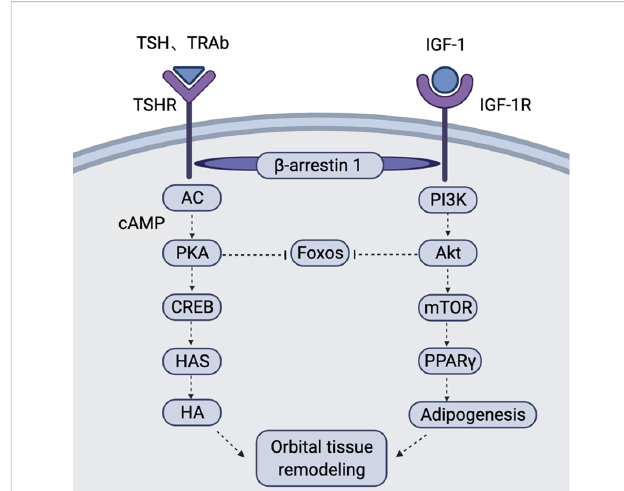
FIGURE 2 Schematic of the TSHR and IGF-1R signalling pathways in the pathogenesis of GO In OFs and OAs of GO patients, TSH and TRAb bind to TSHR to induce activation of AC. This causes an increase in cAMP production and activates PKA. Activated PKA inhibits FOXOs and activates the transcription factor CREB. CREB further acts on